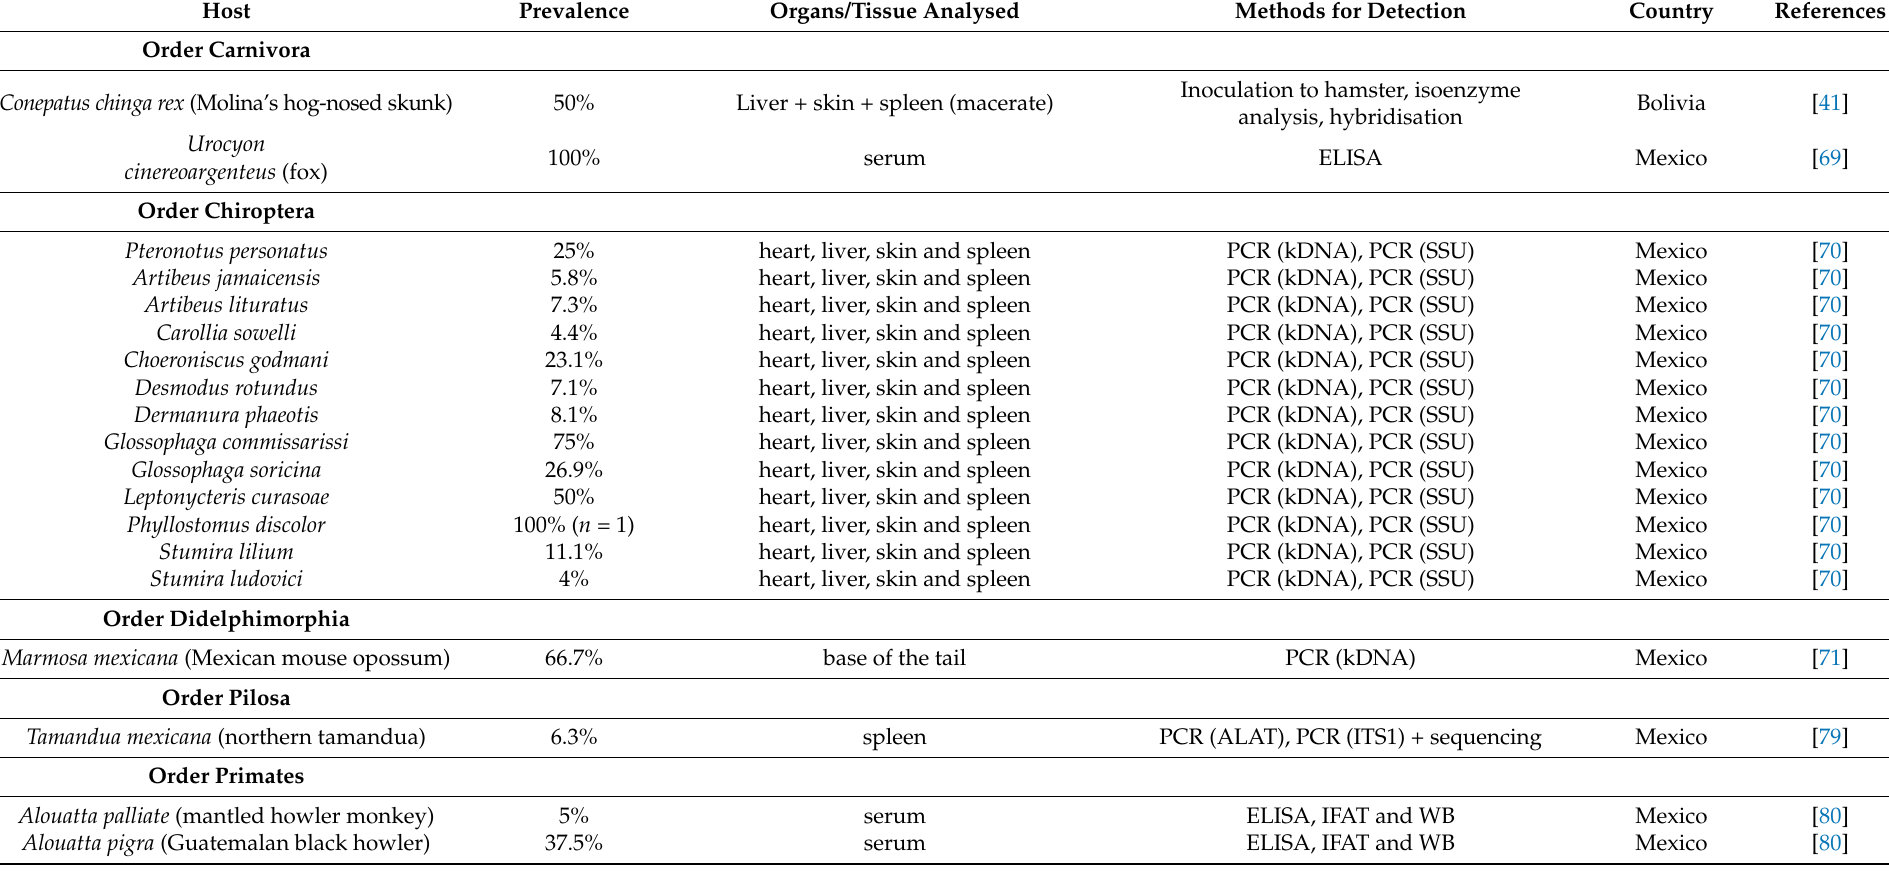
Table 4. Wild animals infected with L. mexicana . Organs or tissues where the parasite was detected, as well as the techniques employed, are